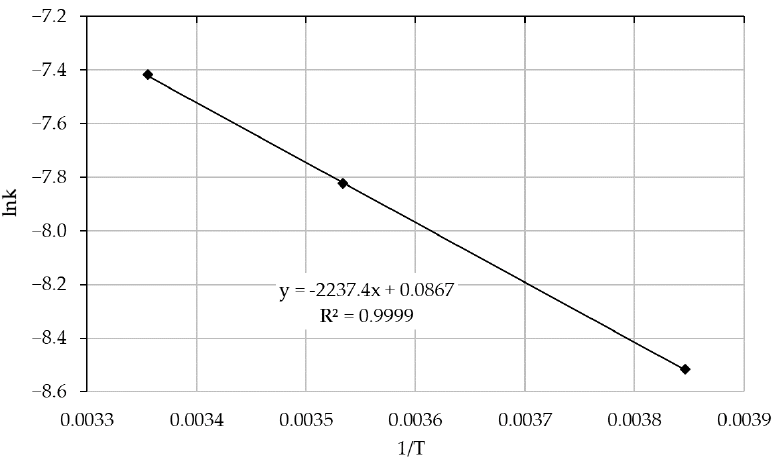
Figure 9. Linear dependence of the reaction rate constant logarithm on the reciprocal temperature.